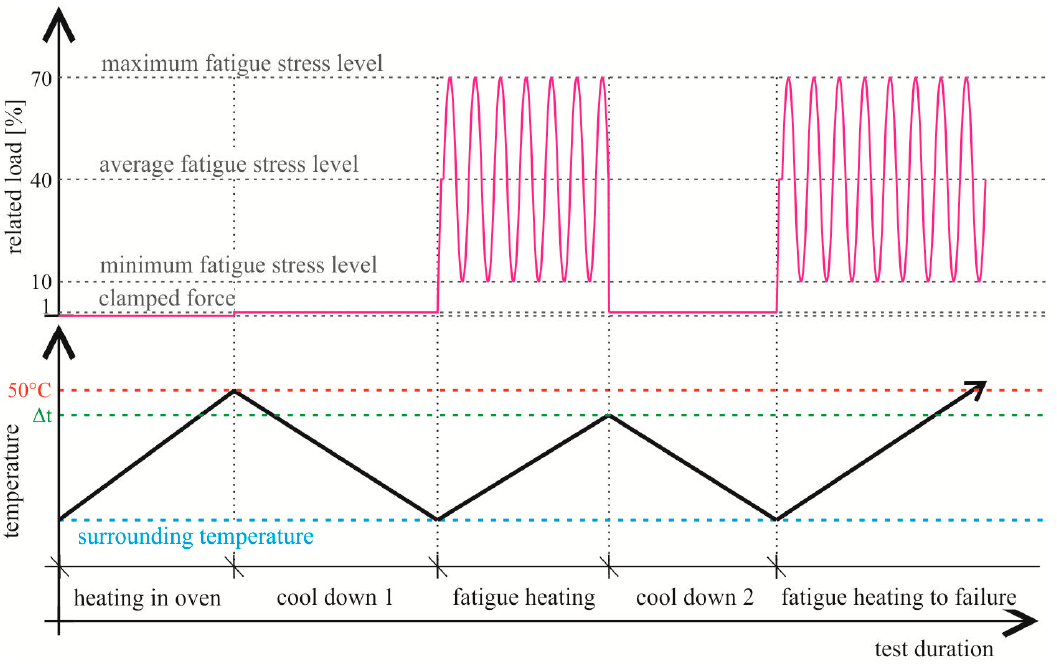
Figure 2. Test procedure for heating and cooling rates for samples no. PK 1T to PK 3T (compare Table 1).